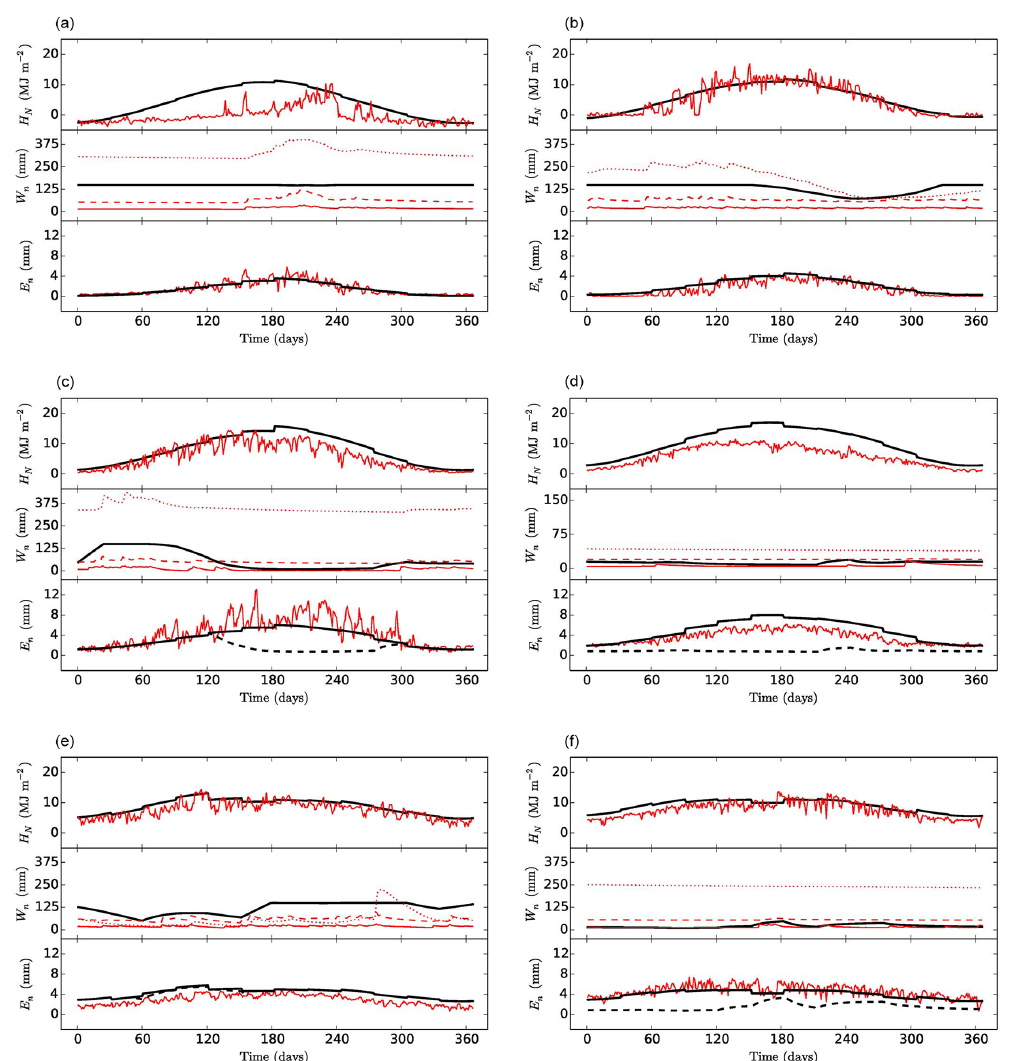
Figure 4. Daily simulations of net radiation, H N , soil moisture, W n , and evapotranspiration, E n , for the six climate regions defined in Fig. 3: (a) tundra, (b) continental with warm summers, (c) temperate with dry summers, (d) hot arid desert, (e) equatorial monsoon, and (f) cold arid steppe. Black lines represent SPLASH modeled net radiation, soil moisture, and evapotranspiration (potential in solid black and actual in dashed black). Red lines represent VIC three-layer modeled surface fluxes from Livneh et al. (2015) for net radiation, soil moisture (layer 1 in solid red, layer 2 in dashed red, and layer 3 in dotted red), and potential evapotranspiration. Days of the year are represented along the x axis. Data are for 1 year